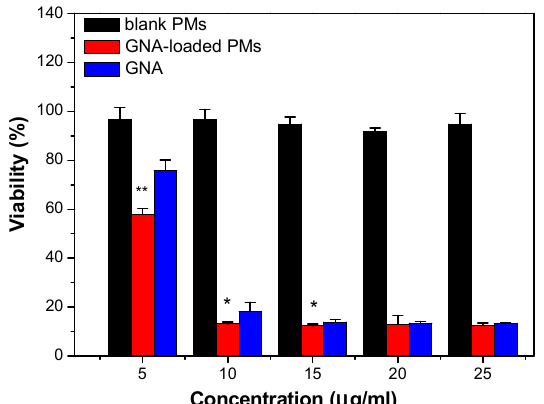
Figure 6. Cell viability of HepG2 cells incubated with GNA, GNA-loaded PMs and blank PMs at various concentrations at 37 °C for 24 h. Error bars denote standard deviations from six parallel trials * p < 0.05, ** p < 0.01. Table 2. IC 50 ( μ g/mL) of HepG2 incubated with GNA solution and GNA-loaded PMs ( n = 6). Formulation